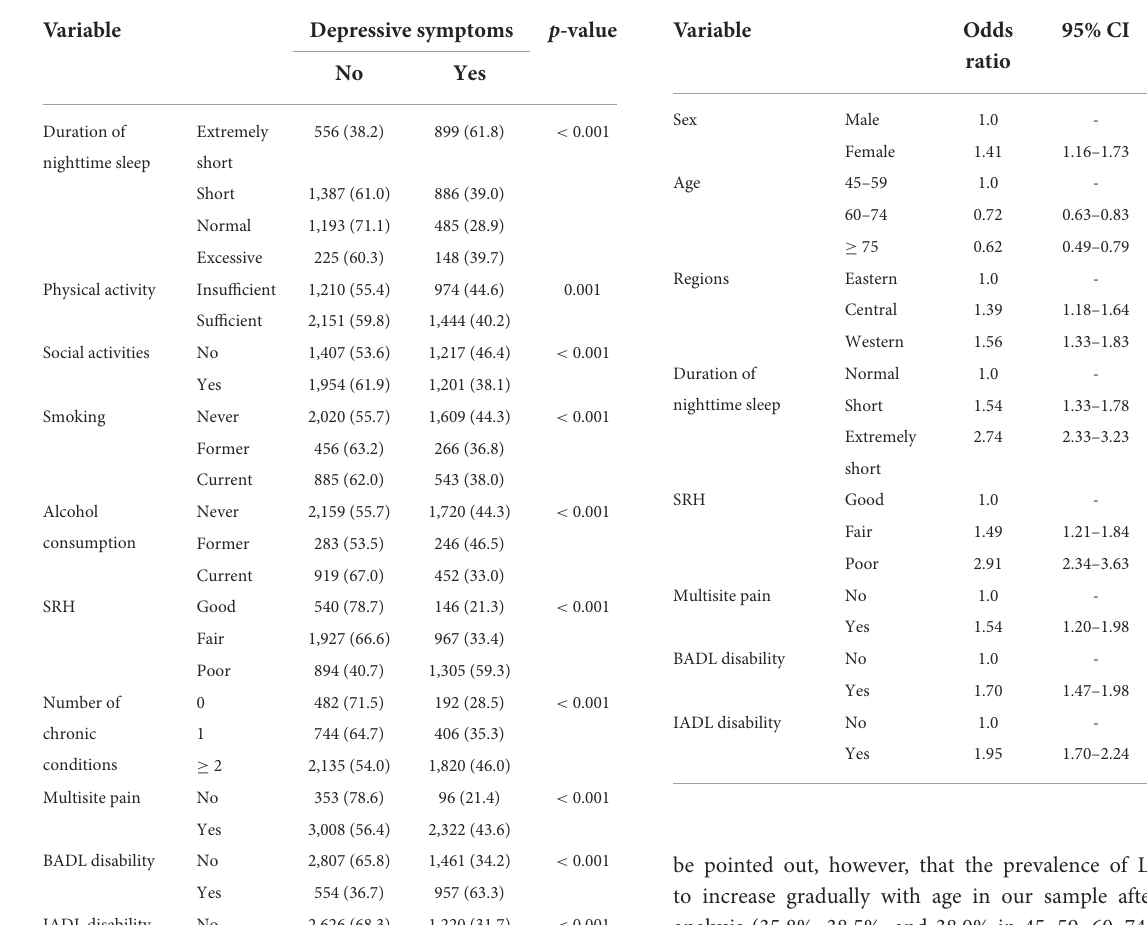
TABLE 3 Multiple regression analysis of factors associated with comorbid depressive symptoms in